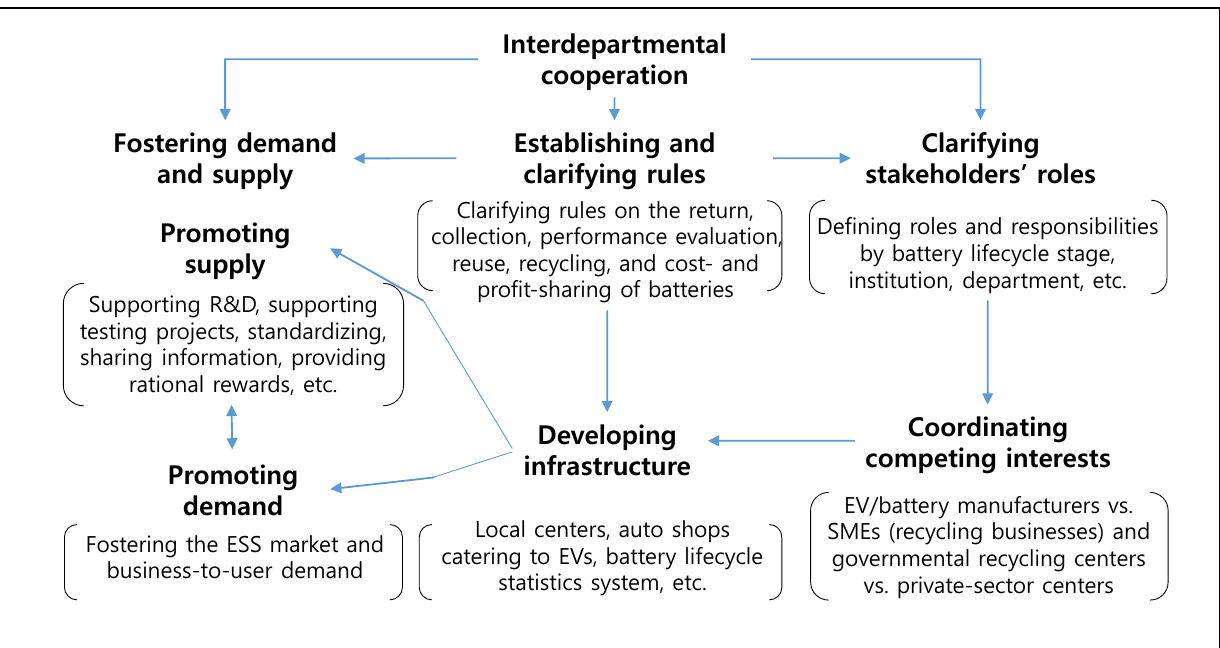
Figure 2. Correlations among policy tasks.